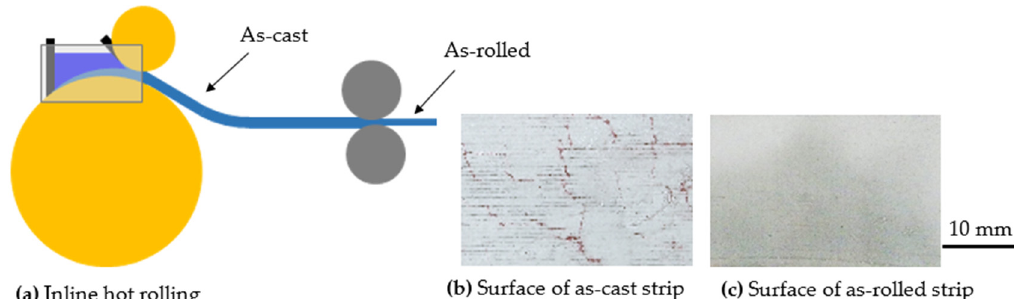
Figure 18. Schematic illustration of inline hot rolling, and surfaces of as-cast strip and as-rolled strip after color check. Aluminum alloy: Al-4.8%Mg, Roll diameter: 300 mm (upper) and 1000 mm (lower), Roll width: 100 mm, Roll speed: 60 m/min, Solidification length: 100 mm, roll load: 13 N/mm.